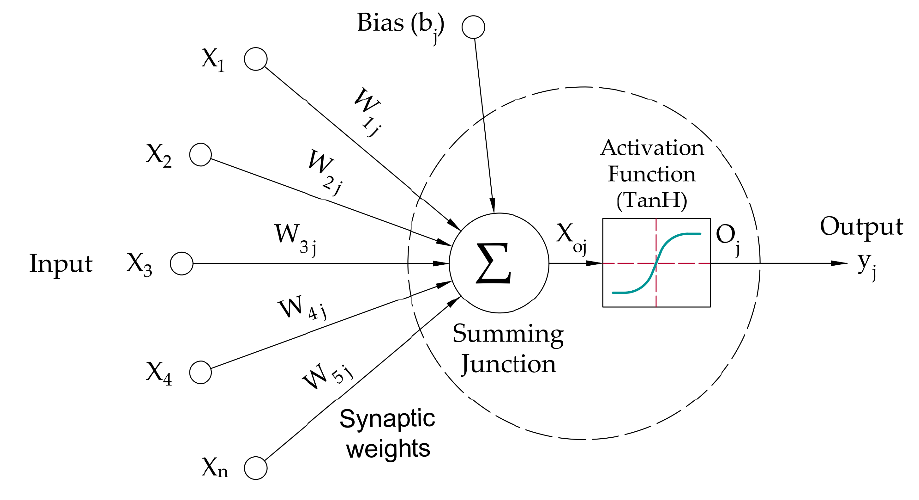
Figure 4. Artificial neural network active node.